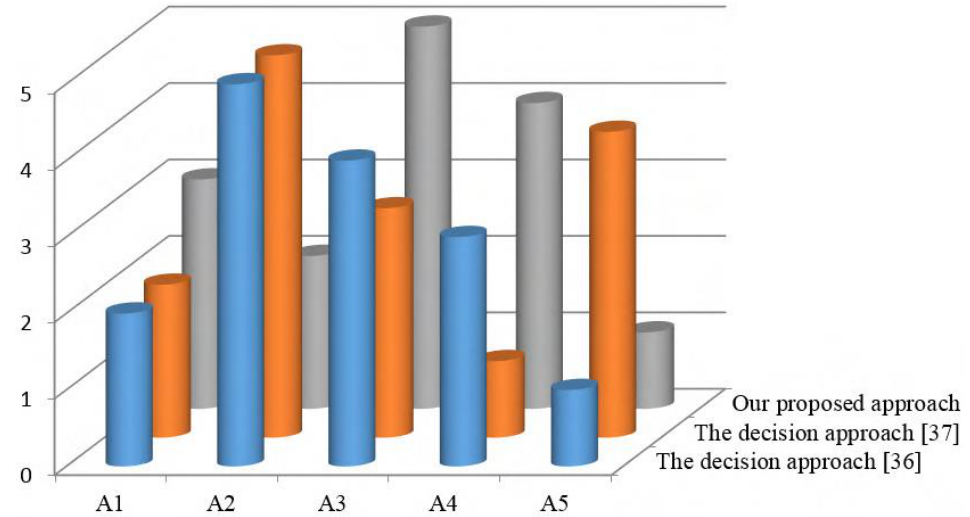
Figure 3. Comparison results of the ranking orders of alternatives by different methods.